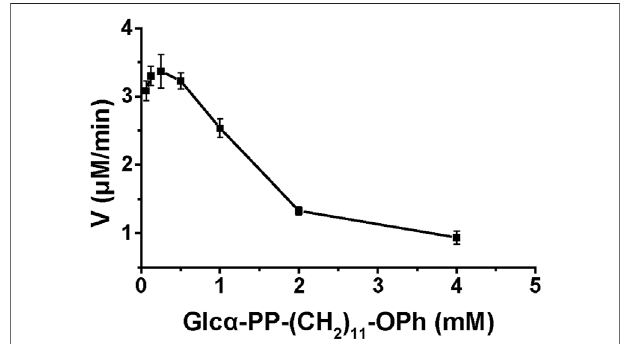
FIGURE 5 | In fl uence of acceptor concentration on enzyme reaction velocity.